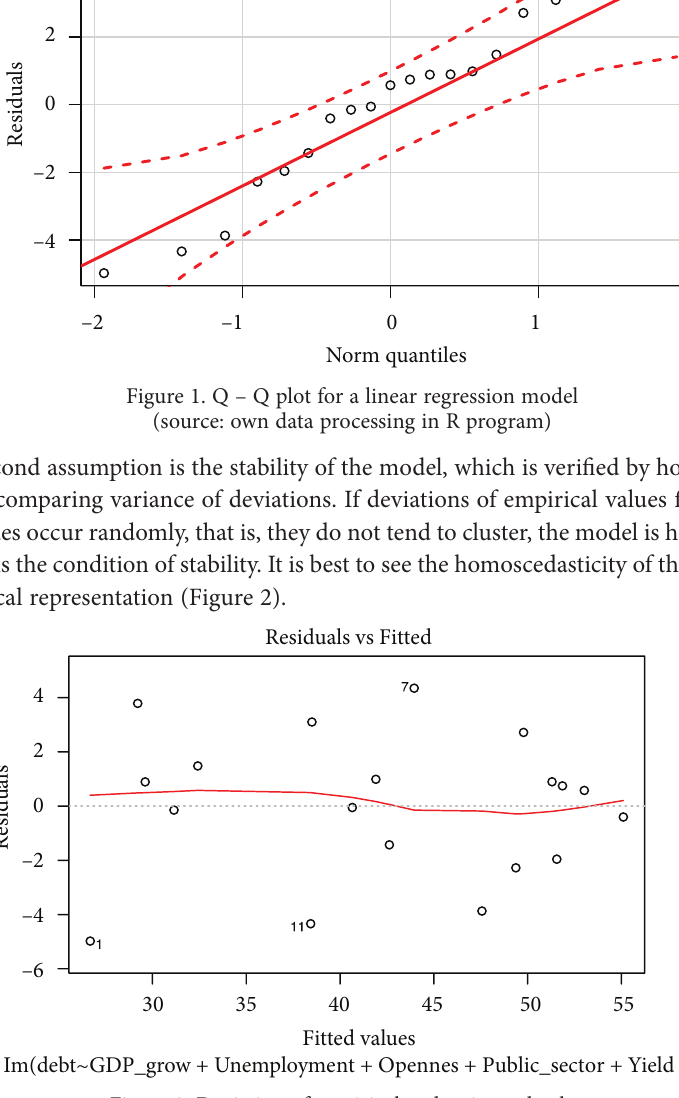
Figure 2. Deviation of empirical and estimated